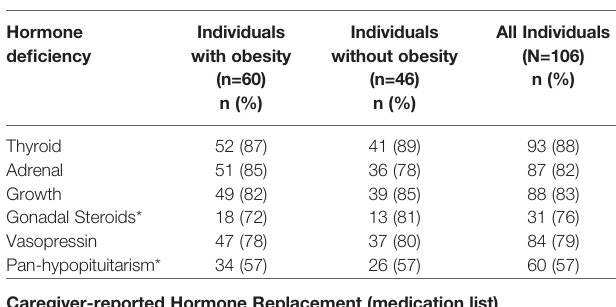
TABLE 2 | Pituitary hormone de fi ciencies.